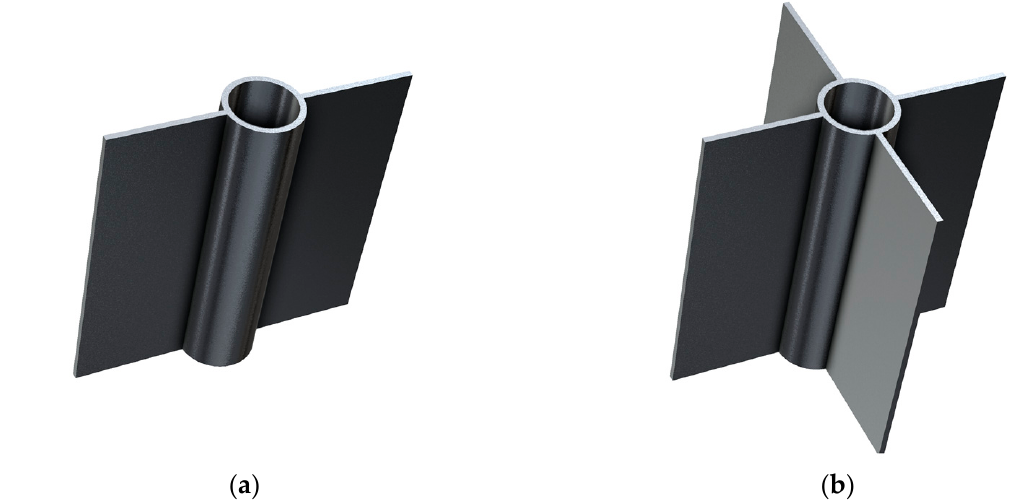
Figure 4. Geometry of longitudinal finned tubes with: ( a ) 2 fins; ( b ) 4 fins.